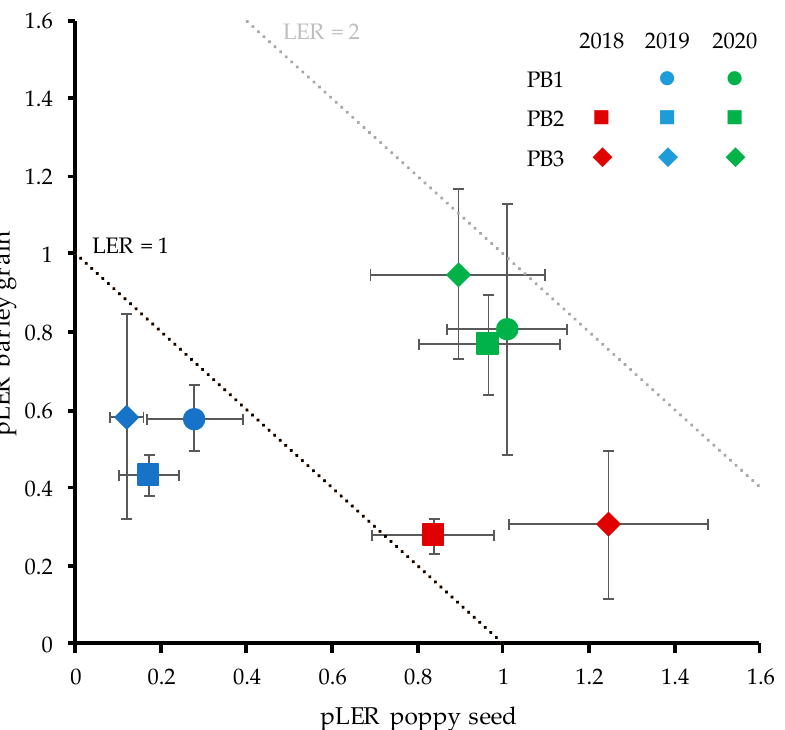
Figure 3. Partial land equivalent ratios (pLER) for poppy and barley yields in the intercropping designs of three different barley seeding densities (PB1 (not in 2018), PB2, PB3) over three years (2018–2020). Symbols and error bars represent means and standard deviations respectively. The dotted lines represent LER = 1 (black) and LER = 2 (grey). Analyses of variance showed no significant differences of LER values between seeding densities within each year.